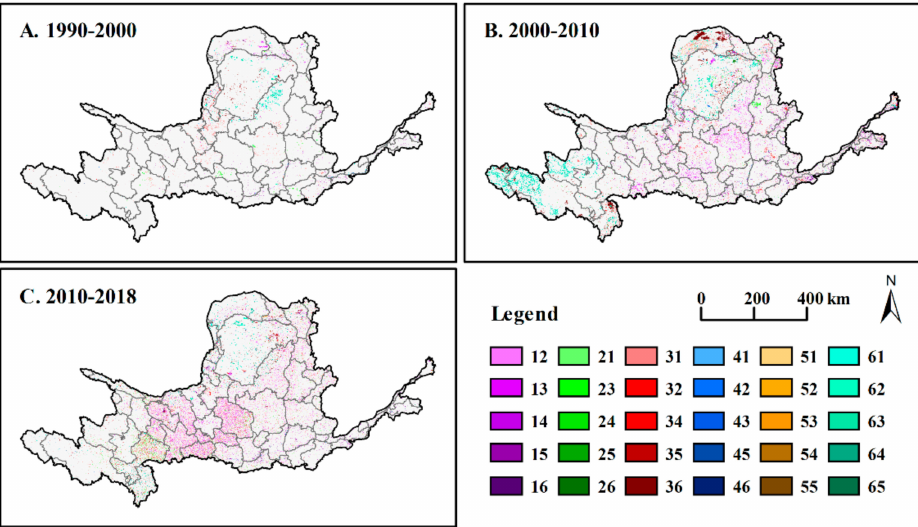
Figure 3. Process Tupu of LUTs during 1990–2018 in the YRB. (Note: A , B and C denotes the Tupu of LUTs during 1990–2000, 2000–2010, and 2010–2018, respectively. The No. 1–6 represent cultivated land, forestland, grassland, water area, construction land, and unused land, respectively. The Tupu units’ codes could be seen in Table A1. For example, Code 12 represents cultivated land converted to forestland, and the other codes follow the same